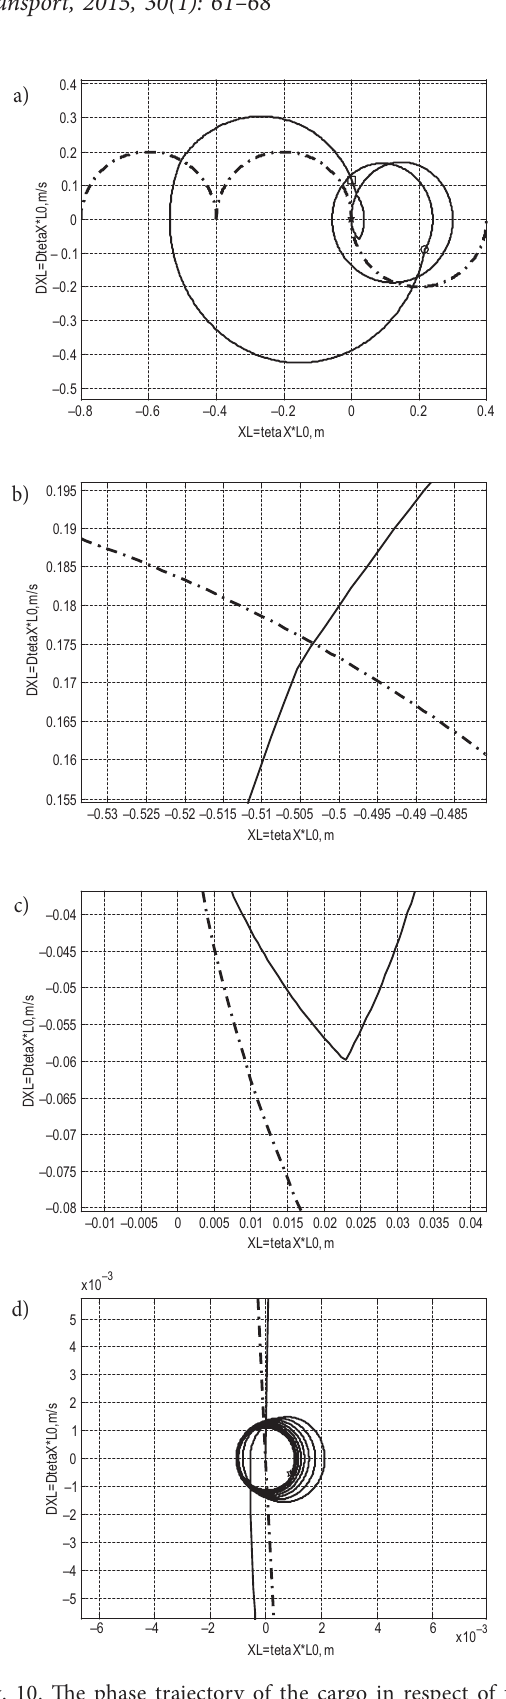
Fig. 10. The phase trajectory of the cargo in respect of the point of attachment on the model and the phase trajectories of changeover (a) 1, 2, 3 – the surrounding of the switching points (closed up): b – Point 1; с – Point 2; d – Point